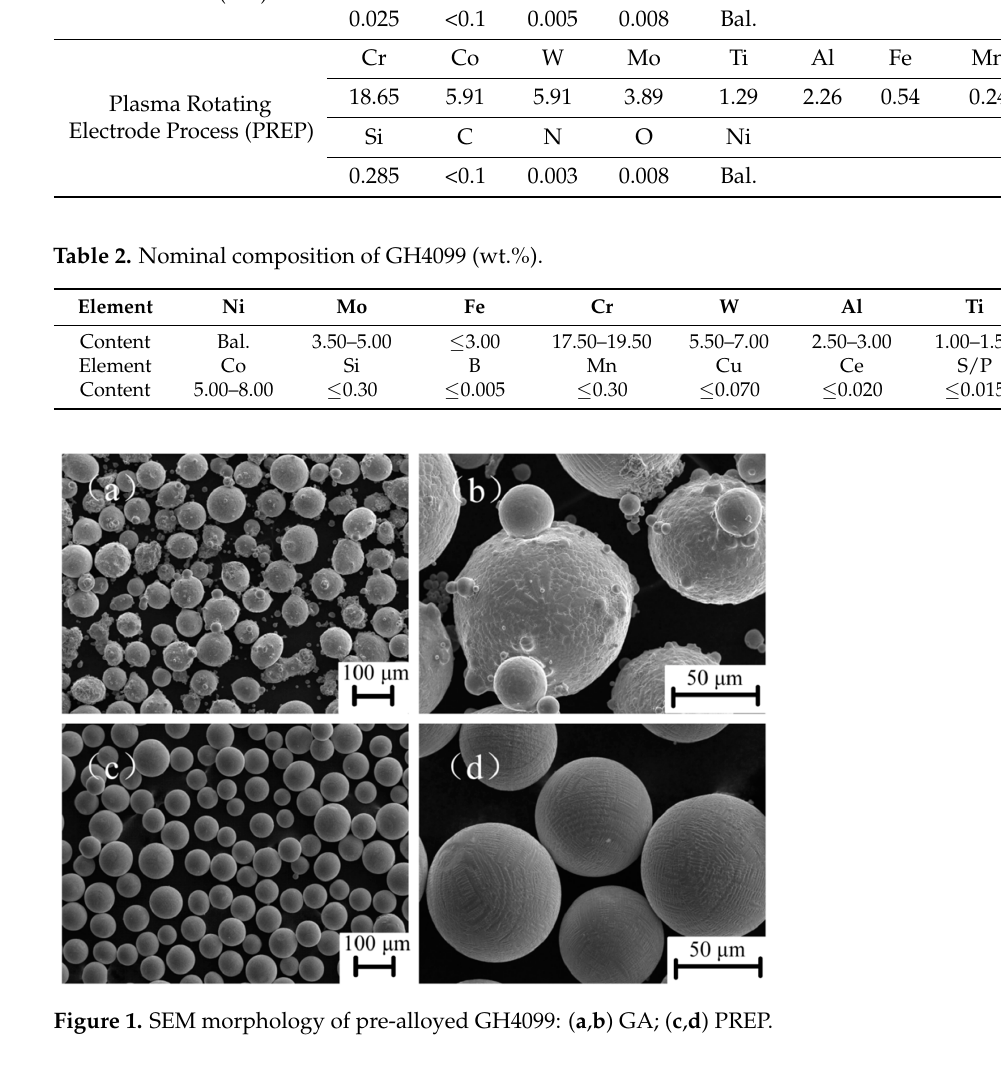
Figure 2. Volume fraction distribution of powder particles. 2.2. EBM Sample Fabrication GH4099 superalloy samples were fabricated using an Arcam A2XX machine (Control Software 3.2, Arcam, Stockholm, Sweden) in a manual mode. Figure 3a shows the sche- matic diagram of one batch of as-EBM samples. Layers were scanned using a snake-like melting strategy (i.e., either 0° or 90° hatch direction was used for each layer), as shown in Figure 3b. A 10 mm thick stainless steel plate with a diameter of 150 mm was used as a starting plate. No supports were applied for the EBM fabrication. One batch of the EBM fabrication included 9 with each 20 value × 20 value × 30 value mm in X-Y-Z dimension. EBM process windows were first established for the GA powders by using a range of scanning speed v from 333–9000 mm/s, combined with a range of line offset L off from 0.1– 0.3 mm, followed by the PREP powders. Three different beam current I values of 5 mA, 10 mA, and 15 mA were selected. This resulted in equivalent area energy E A values rang- ing from 0.414 J/mm 2 to 3 J/mm 2 . This resulted in equivalent area energy E A ( E A = UI /( v · L off ), where U is the operating voltage of 60 kV) values ranging from 0.414 J/mm 2 to 3 J/mm 2 . A